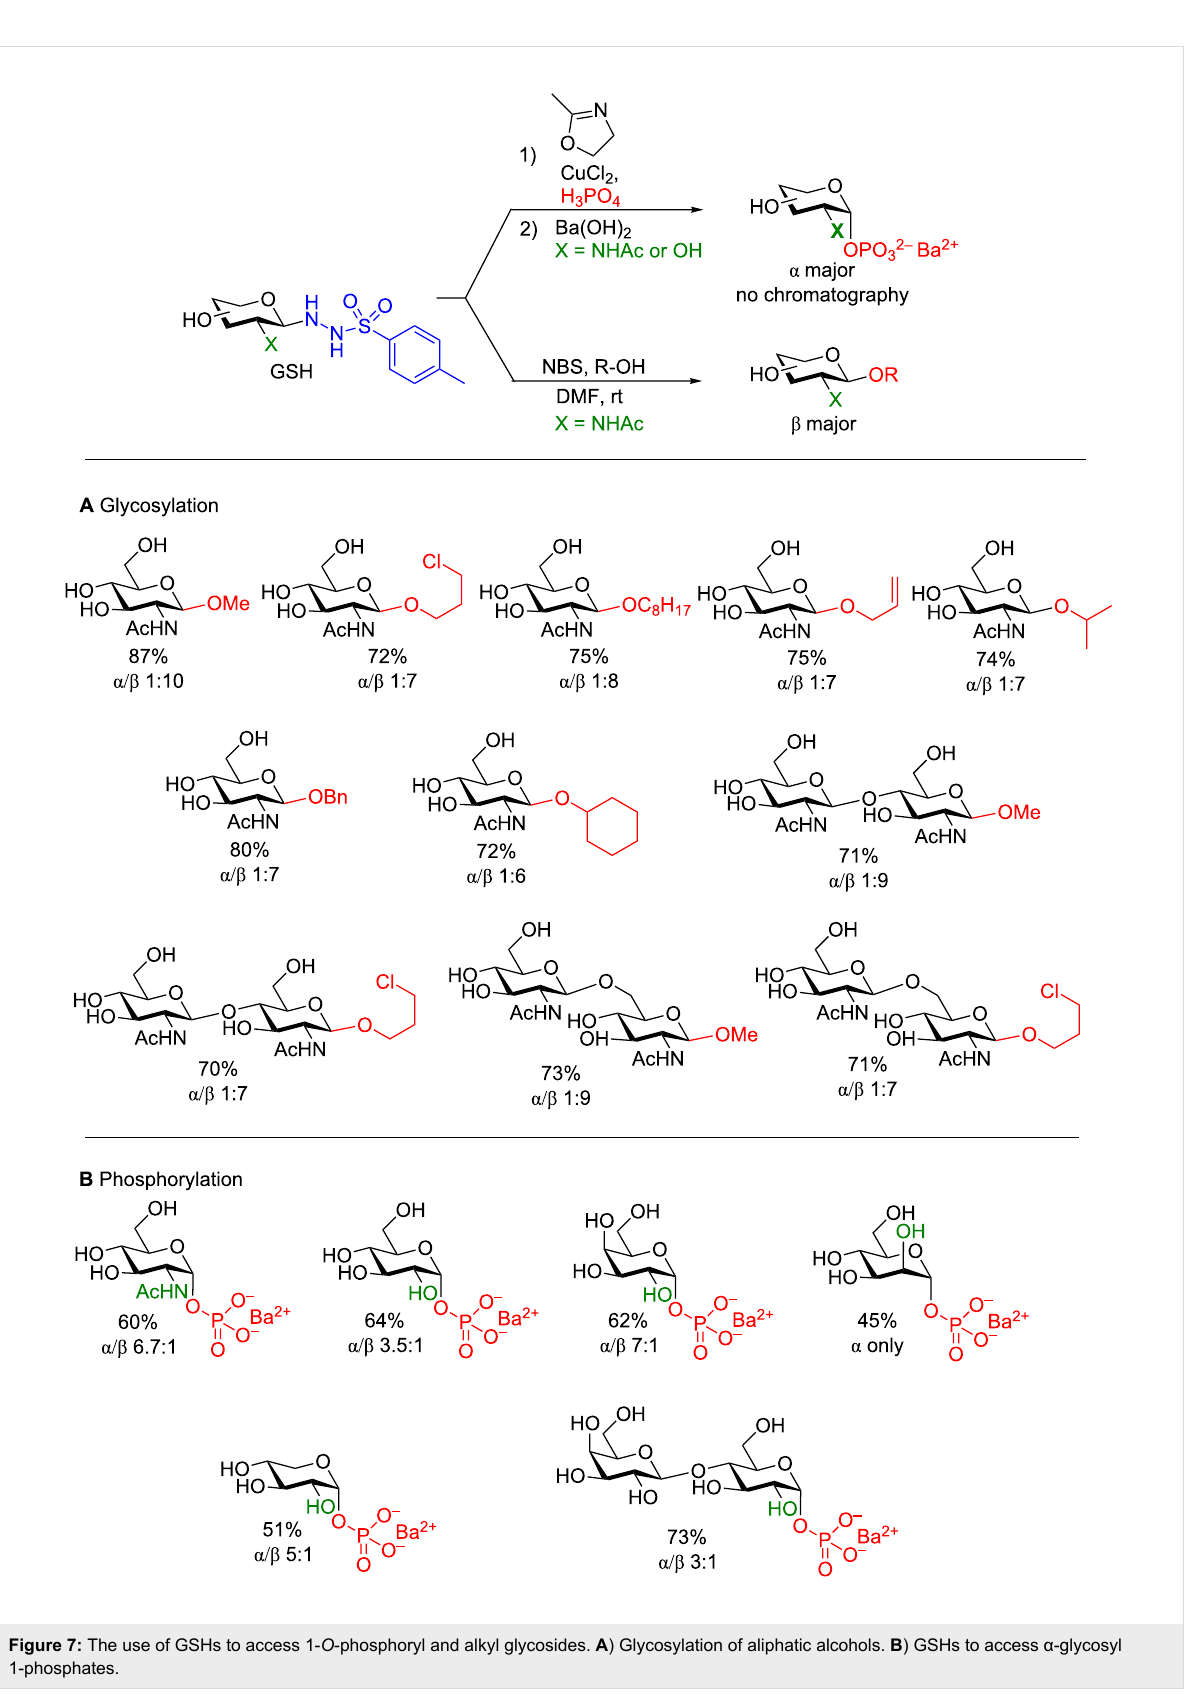
Figure 7: The use of GSHs to access 1- O -phosphoryl and alkyl glycosides. A ) Glycosylation of aliphatic alcohols. B ) GSHs to access α -glycosyl